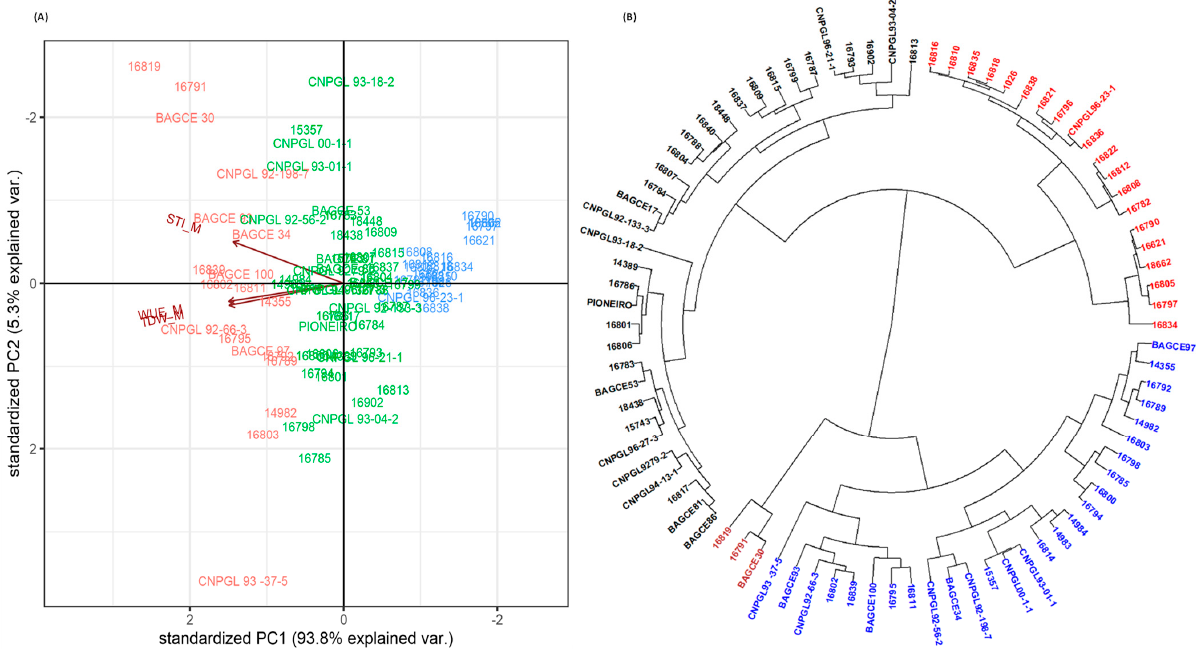
Figure 4. Grouping by drought stress response of Napier grass genotypes, based on STI, WUE and TDW, under moderate water stress using: ( A ) PCA and ( B ) cluster analysis. Both analyses discriminate highly tolerant, moderately tolerant and susceptible genotypes. Water use efficiency (WUE), total dry weight (TDW) and stress tolerance index (STI).